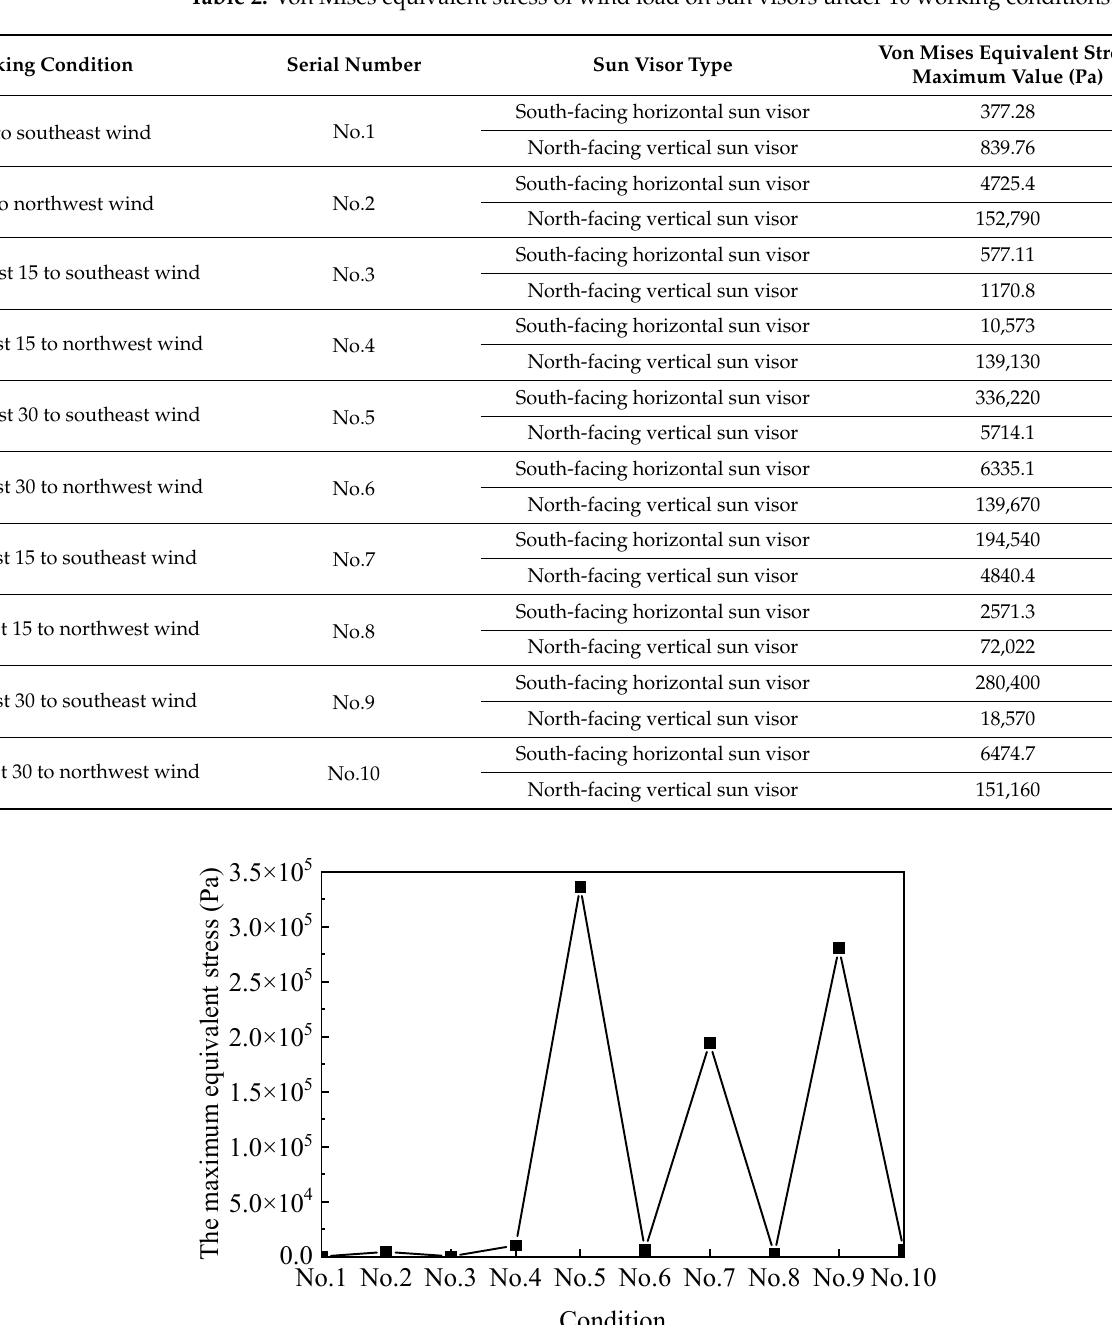
Table 2. Von Mises equivalent stress of wind load on sun visors under 10 working conditions.